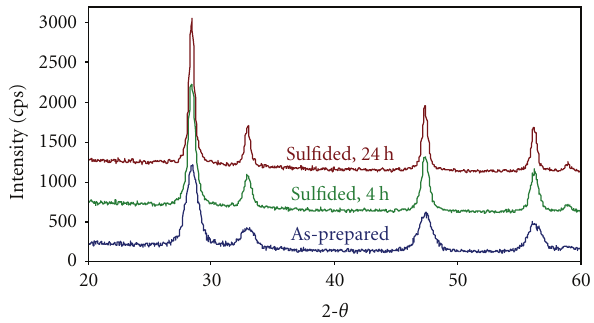
Figure 5: Comparative XRD patterns of the unsulfided and postsulfided (1000ppm H 2 S/bal. N 2 . at 800 ◦ C for 4 and 24 h) bimetallic powders of the catalyst RuPd.